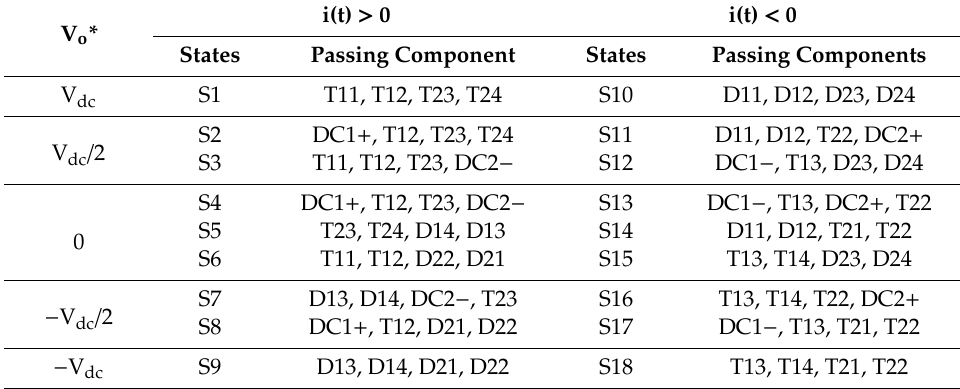
Table 2. Possible voltage levels and states for the single-phase HB-5L-NPC